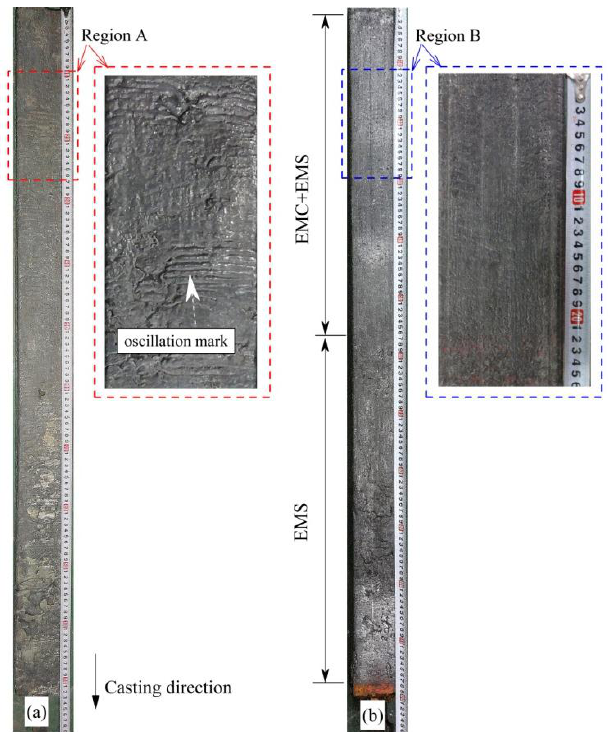
Figure 2. The surface topographies of Incoloy800H superalloy billets. Billets obtained from ( a ) Set I and ( b ) Set II. The depths of the oscillation marks decreased from 1.2 mm to 0.3 mm due to the effect of the alternating electromagnetic field.